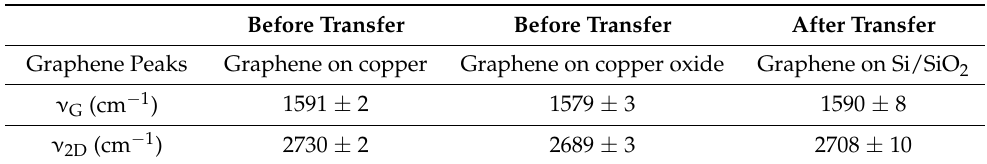
Table 1. Comparison of the positions of graphene’s G and 2D peaks before and after transfer, from a Raman map of a graphene single crystal obtained from Figure